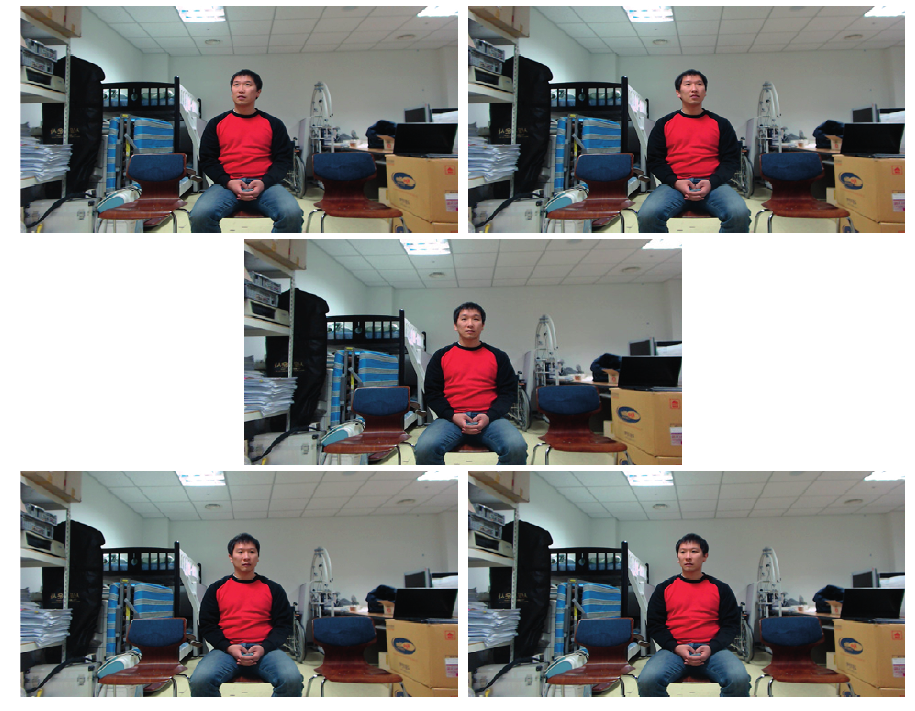
Figure 15. Examples of test images: ( a ) Examples of images for enrollment (where a user looks at top-left, top-right, middle, bottom-left, and bottom-right positions on the TV, respectively); ( b ) Examples of images for